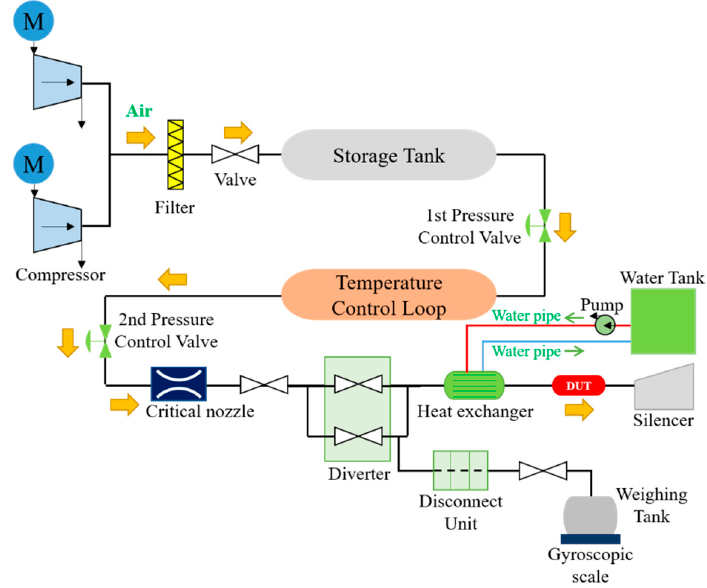
Figure 2. High pressure gas flowrate standard system at Korea Research Institute of Standards and Science (KRISS).